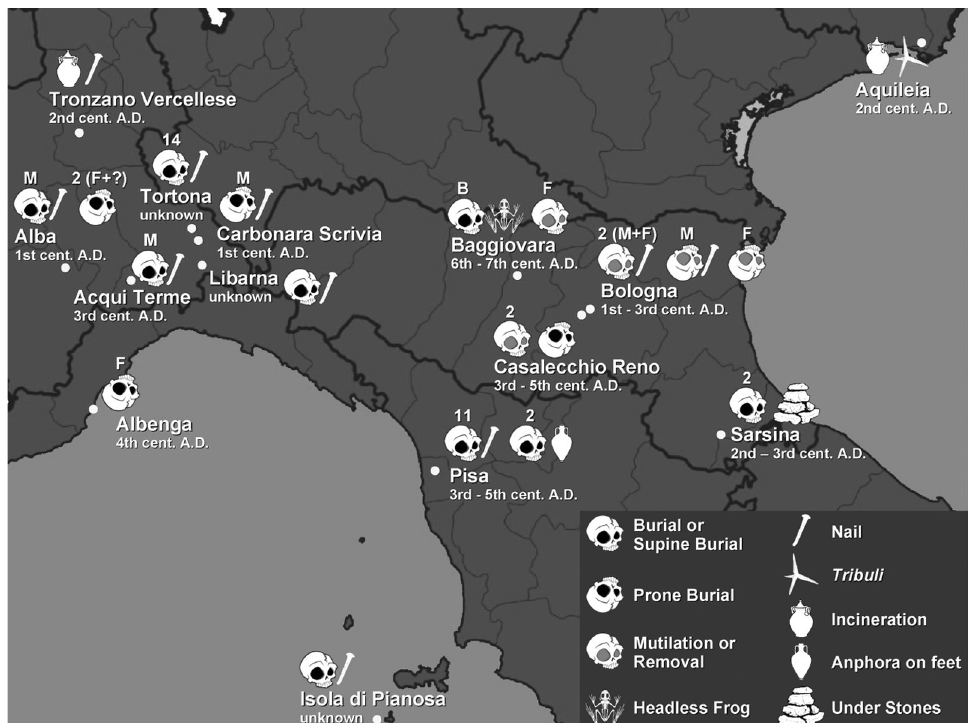
Figure 1: Distribution of anomalous burials in Roman northern